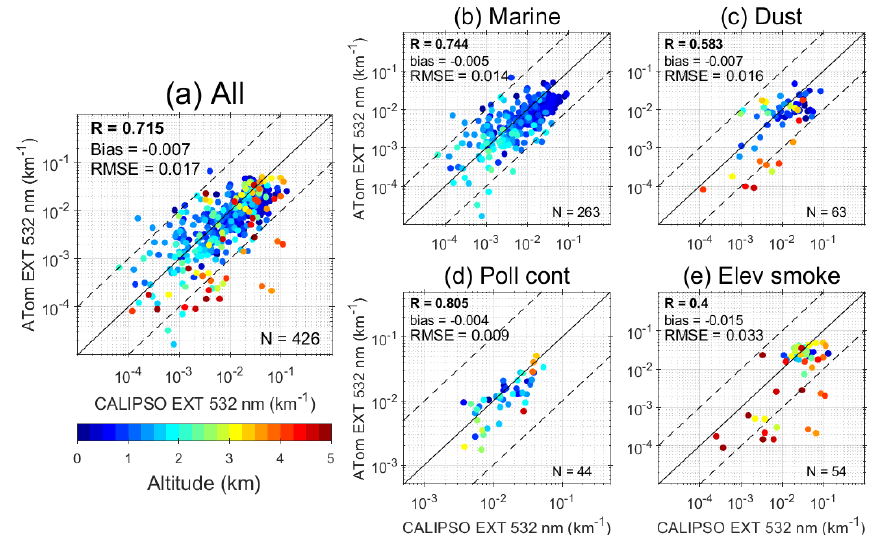
Figure 5. Comparison of the dry aerosol extinction coefficient from CALIOP observations and ATom measurements between the surface and 5km altitude, with the data regridded to a profile with 240m bin width and colours referring to the altitude of the measurement (a) . The bins where marine (b) , mineral dust (c) , polluted continental (d) , and elevated smoke (e) aerosols are dominant are shown separately. Spearman’s correlation coefficient ( R ), bias, the root mean squared error (RMSE), and the sample space ( N ) are given in the legend. The solid lines represent the identity line, and the dotted lines on either side of it represent 1 order of magnitude from the identity